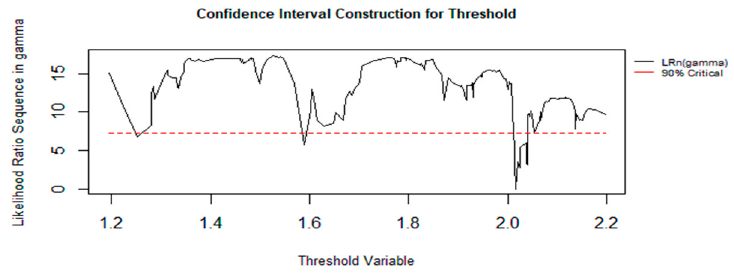
Figure 2. Threshold estimator diagram for Model 1. Note: authors’ calculation.